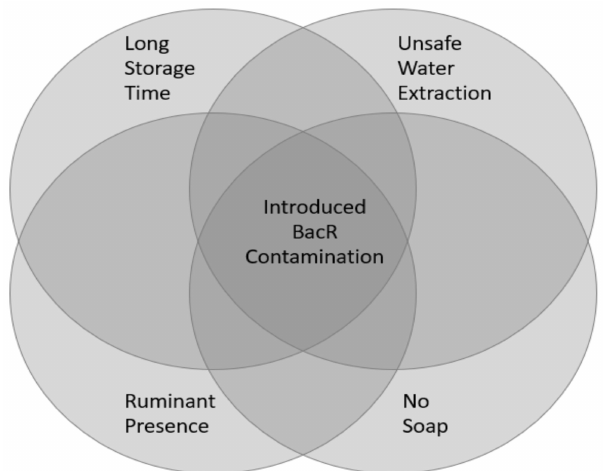
Figure 1. Conceptual model of the interconnected factors that are associated with the introduction of ruminant contamination to a household’s stored water